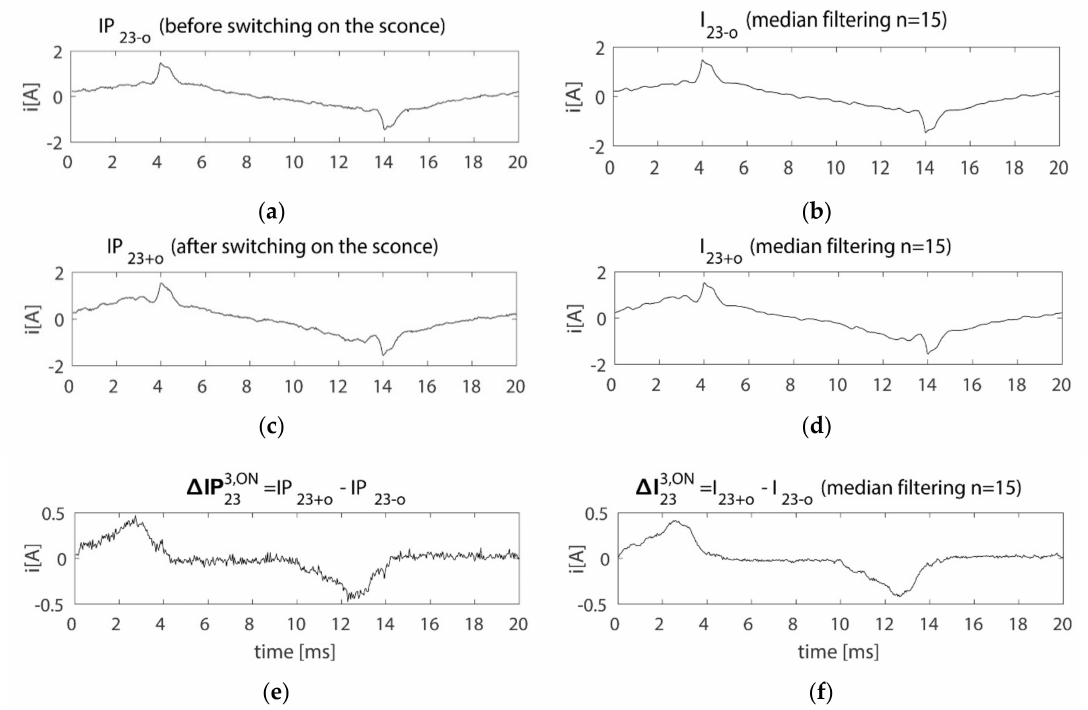
Figure 6. Determination of changes in the current signal—determination of the vector of changes ∆ IP ( a , s ) , on the unfiltered signal ( a , c , e ) and the change vector ∆ I k the 15th order ( b , d , f ) for k = 23, a = 3, s = ON, o = 15. (Before the analyzed event took place, another 7 EAs was already on, working in the